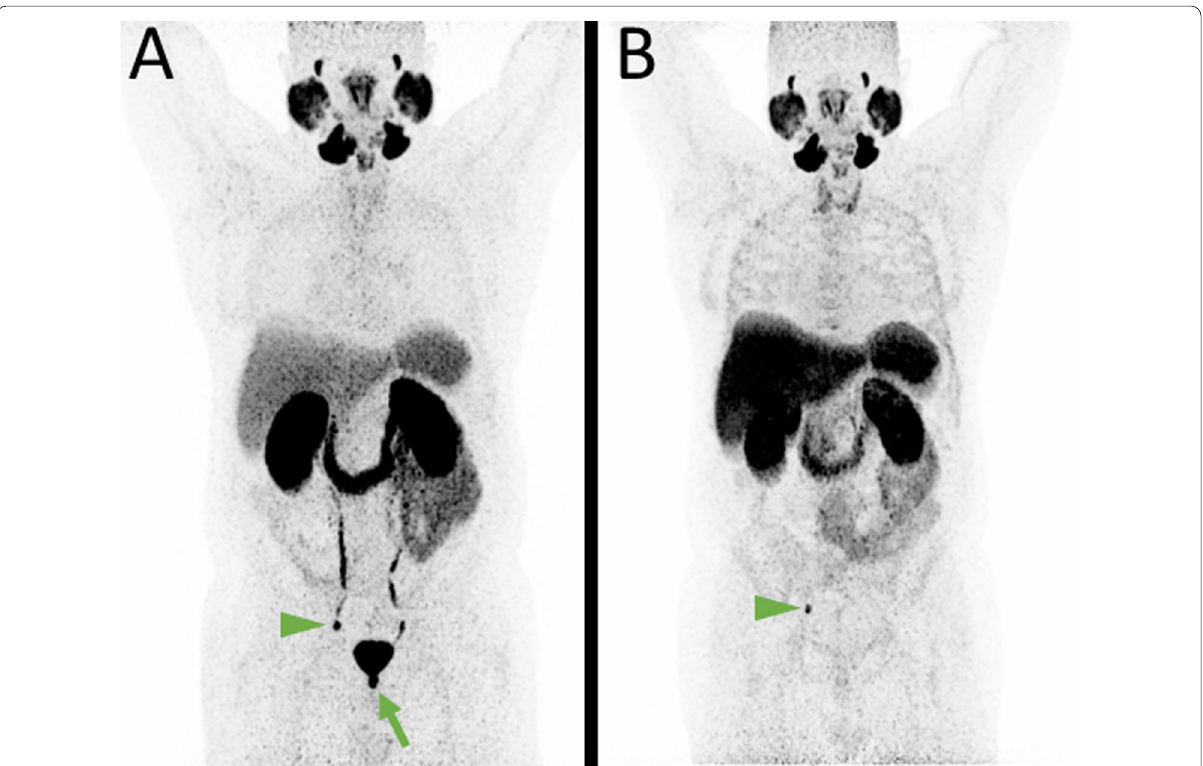
Fig. 5 MIP of [ 68 Ga]-Ga-PSMA-11 ( A ) and [ 18 F]-F-PSMA-1007 PET ( B ). Only in the [ 68 Ga]-Ga-PSMA-11 PET, intense uptake in the prostatic fossa is noteable (green arrow). The absence of any uptake in [ 18 F]-F-PSMA-1007 PET suggests the presence of urinary retention. Concordantly present external iliac lymph node metastasis on the right (arrow heads). However, in [ 18 F]-F-PSMA-1007 PET due to missing ureteral activity, the demarcation is much better. Auxiliary finding in B Disseminated presumable unspecific uptake in the skeleton and moderate thyreoidal uptake